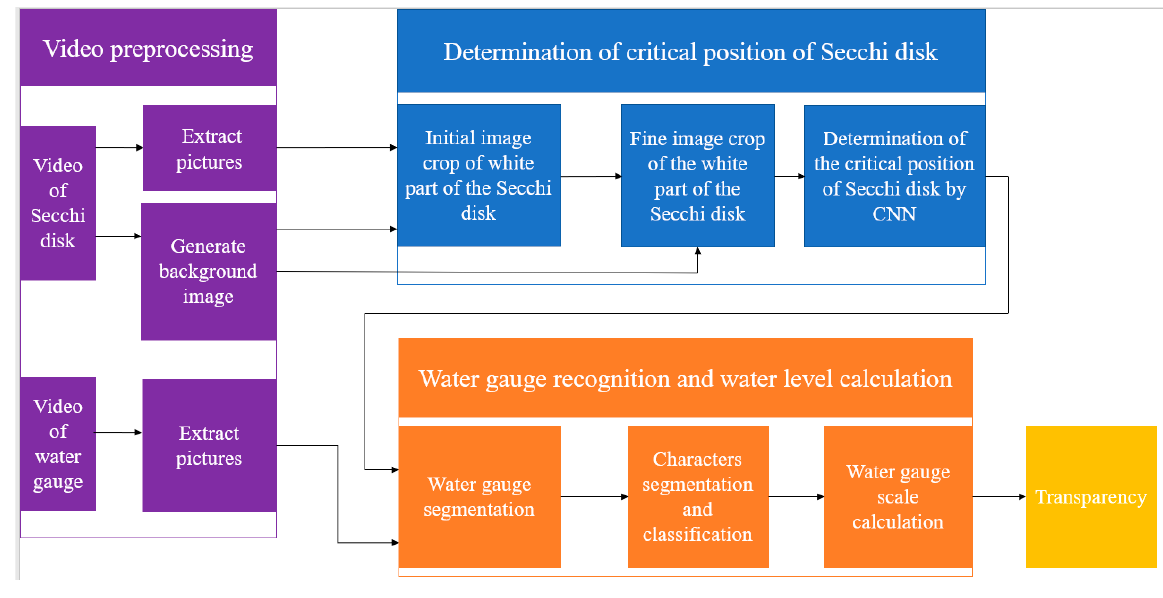
Figure 1. Overall framework of the algorithm.